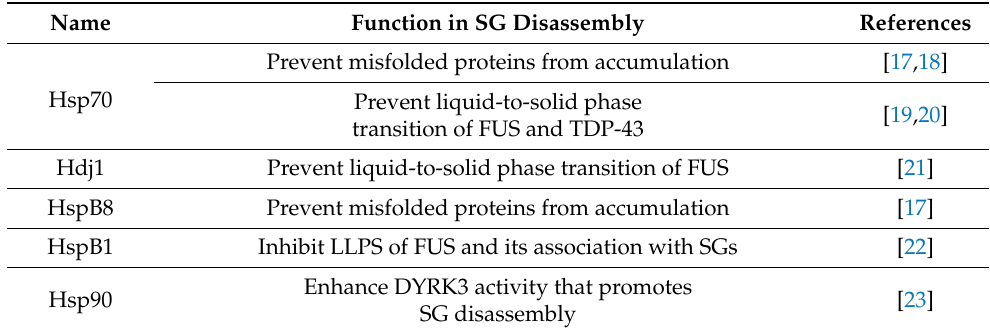
Table 1. Chaperones in SG